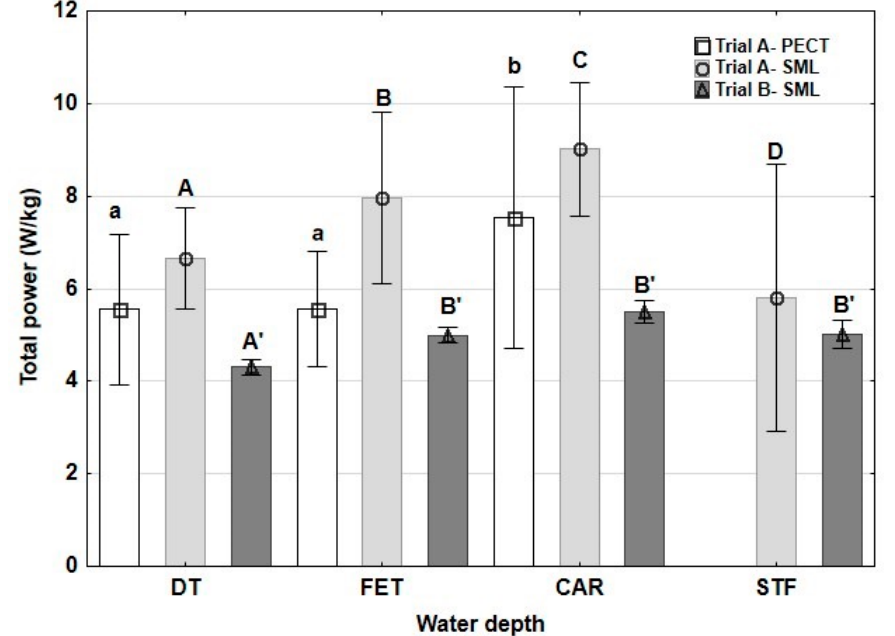
Figure 1. Means and standard deviations (whiskers) of total power measured in horses exercised on a water treadmill at different water depths and velocities. DT: dry treadmill, without water; FET: water at the level of the fetlock; CAR: water at the level of the CAR; STF: water at the level of the stifle. Trial A-PECT: accelerometer fixed in the pectoral region with velocities of 6 km/h; Trial A-SML: accelerometer fixed in the sacrum midline at velocities of 6 km/h with the water at DT, FET and CAR and at a velocity of 5 km/h with the water at STF; Trial B-SML: accelerometer fixed in the sacrum midline at a velocity of 5 km/h in the four water depths. Lowercase letters: significant differences between water depths in trial A-PECT; capital letters: significant differences between water depths in trial A-SML; capital letters with apostrophes: significant differences between water depths in trial B-SML. Different letters indicate significant differences between water depths at each trial p < 0.05.